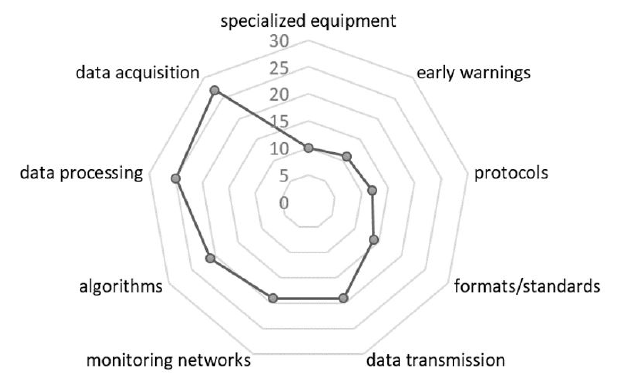
Figure 4. Identified